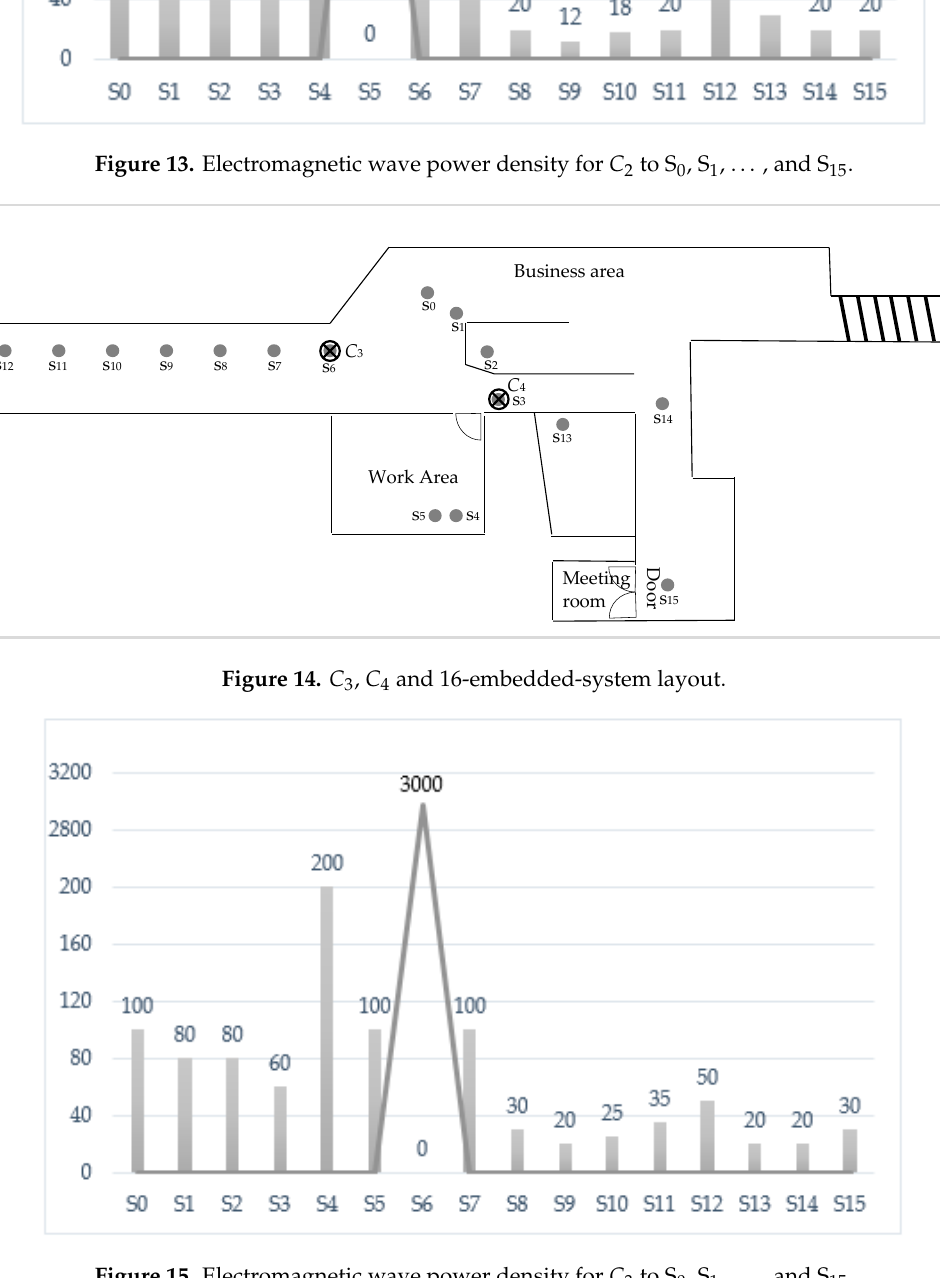
Figure 16. Electromagnetic wave power density for C 4 to S 0 , S 1 , …, and S 15 . 5. Conclusions Embedded systems with smaller, cheaper, and easier-to-implement characteristics are more popular for designing smart objects, devices, applications, or services. Recently, there has been an increasing number of functions, such as wired, wireless, or/and sensor peripherals that are integrated into embedded systems to provide interconnected and collaborating services. As diverse embedded systems are continually set and joined up to smart offices, either electromagnetic wave power density or the communication strength is a significant issue considering energy-saving or cooperation work for all embedded systems. This work studied the layout of multiple embedded systems for communication strength and electromagnetic wave power density optimization. Our prior works measured the original data of electromagnetic signal strength and power density for smart offices, shown in Figure 3. For the issue of electromagnetic signal strength, we analyzed deployment topology into an n -shaped layout and an n -shaped layout with a door in smart offices. In the n -shaped